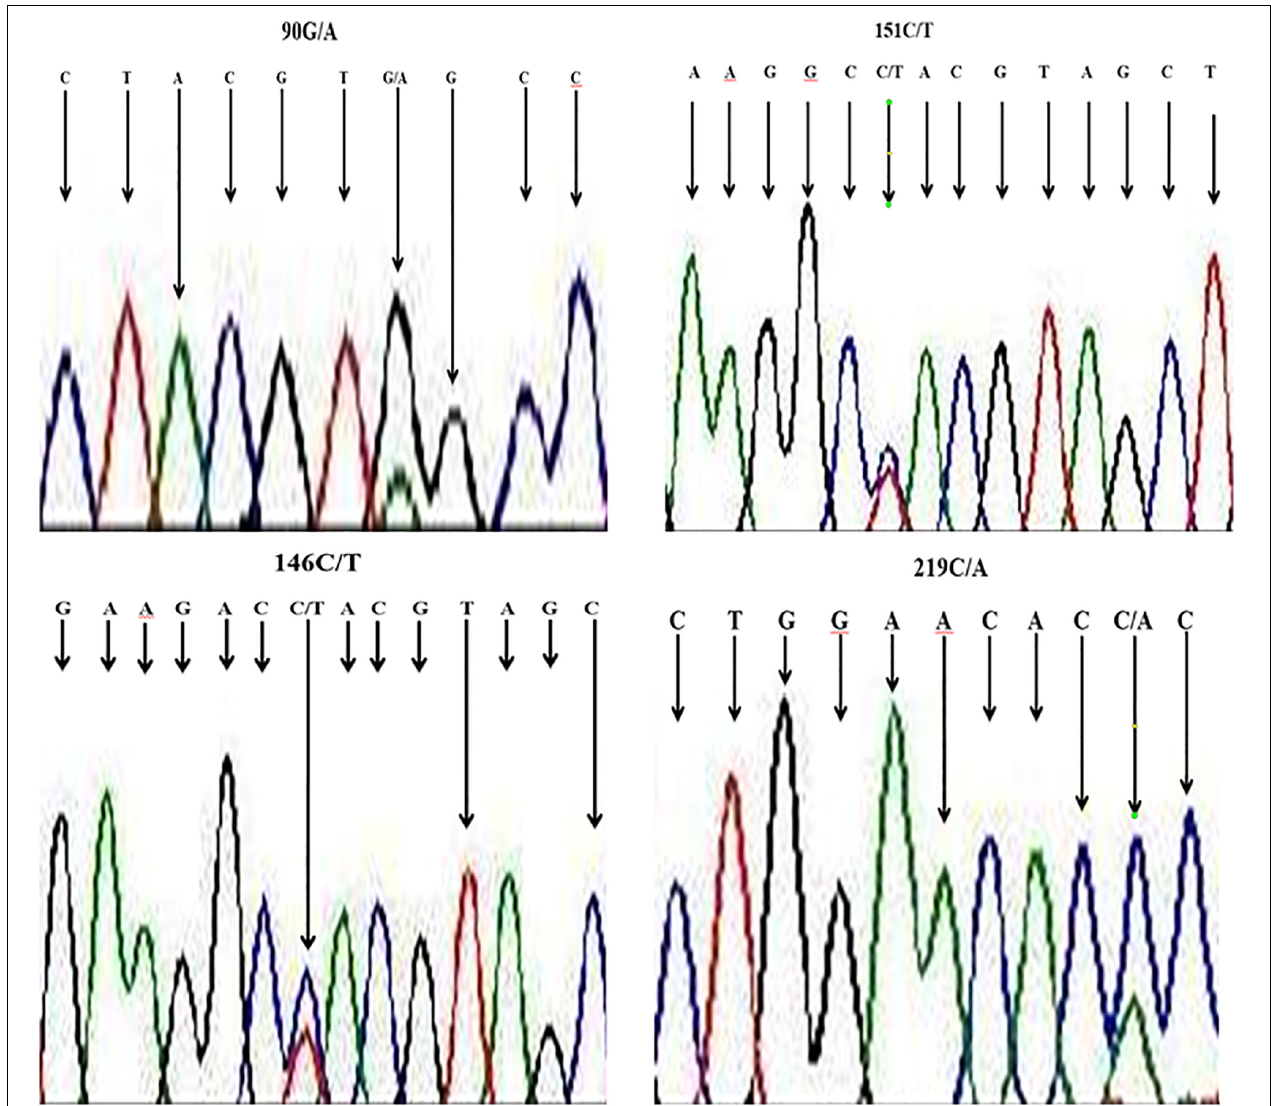
FIGURE 2 | Section of sequence map at HSP 70 showing sites with base exchange (SNP) in DNA samples of Nigerian zebu cattle.